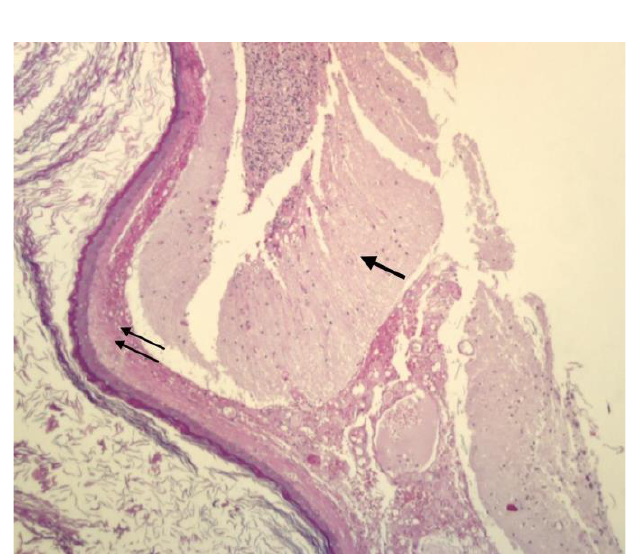
Fig 4. Microscopic view showing normal cerebellar parenchyma (Thick black arrow) limited by dermoid cyst wall (Double back